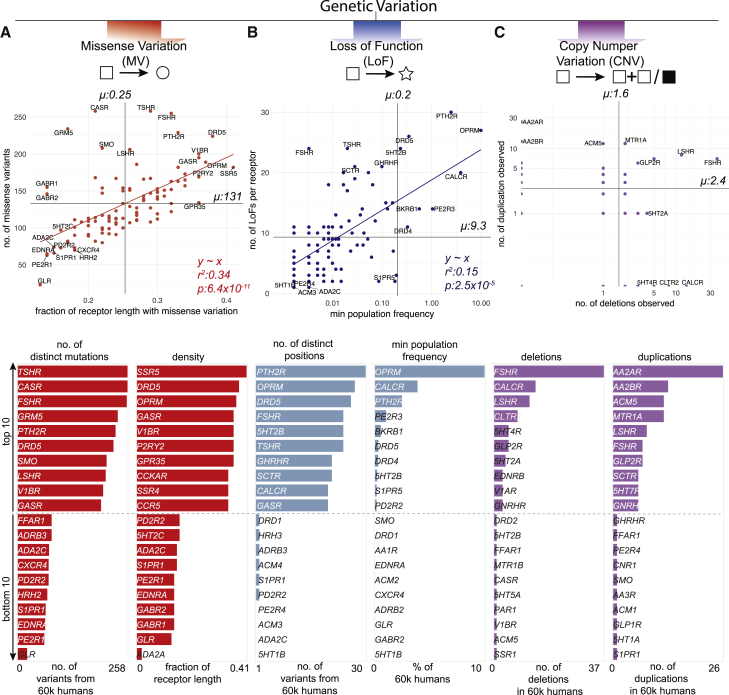
Genetic Variation Landscape of GPCR Drug Targets(A–C) Scatterplots of (A) missense variation (red), (B) loss-of-function mutations (blue), and (C) copy-number variation (purple) for GPCR drug targets. Each mutation type shows the number of observed variants (separated into deletions and duplications for CNVs) for a given GPCR drug target. Missense variation density was obtained by normalizing number of missense mutations to the receptor sequence length. Loss-of-function mutations are presented as the minimum percentage of individuals harboring at least one copy of a protein-truncating variant (STAR Methods). Correlations and mean values (μ) are shown for MVs and LoFs. Mean values (μ) for the distributions are provided. Genetic variation landscapes of GPCR drug targets that are in clinical trials are provided in Table S3 and S4). Lower half of the figure shows the distribution of top 10 (upper panels) and bottom 10 ranking GPCR drug targets (lower panels).See also Figures S1, S2, and S3.